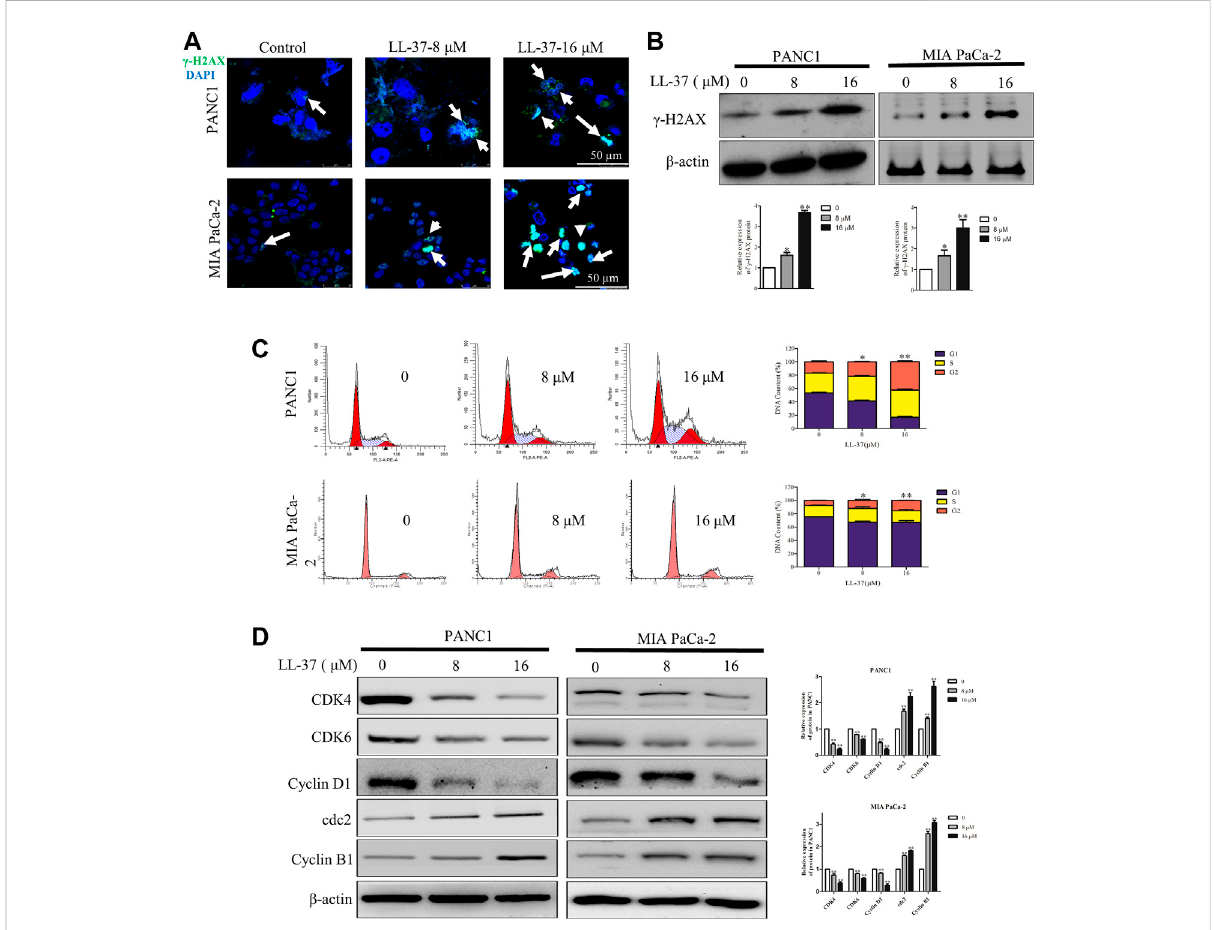
FIGURE 2 LL-37 induces DNA damage and cell cycle arrest in pancreatic cancer cells. LL-37 induced DNA damage by increasing γ -H2AX expression, as determined by immuno fl uorescence microscopy and western blotting (A,B ), respectively after LL-37 (8 and 16 μ M) treatment for 24 h. (C) The cell cycle distributions in PANC1 and MIA PaCa-2 cells were analyzed by fl ow cytometry after LL-37 treatment for 24 h. The data are presented as means ± SD. * p < 0.05, ** p < 0.01 vs . control (0 μ M) value in the G2 phase. (D) The expressions of cell cycle arrest related proteins were determined by western blotting after LL-37 treatment for 24 h. Non-arbitrary band density data relative to the housekeeping protein ß -actin are presented as mean ± SD, * p < 0.05, ** p < 0.01 vs. control (0 μ